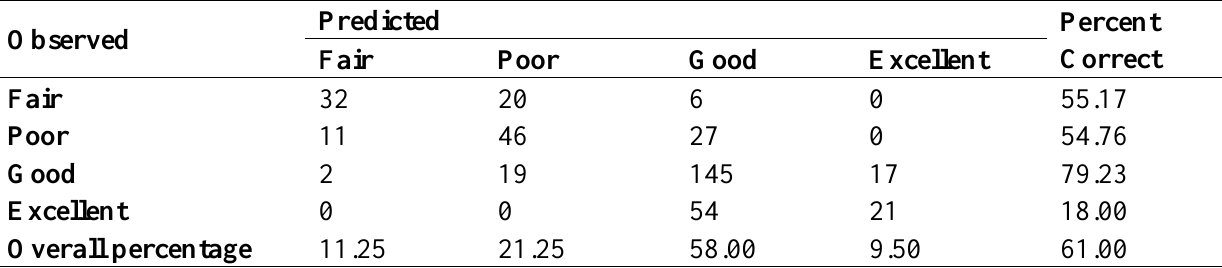
Table 5. Classification results using the first level of riding quality model (multinomial logit model).